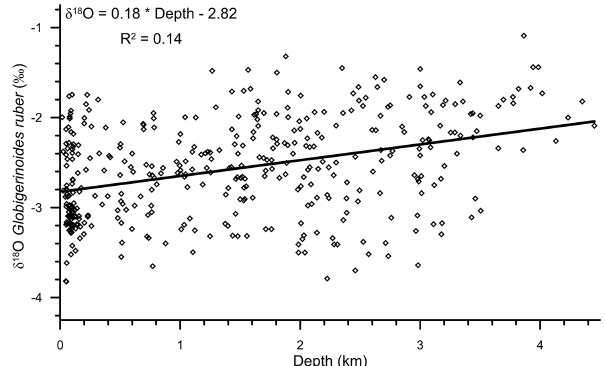
Figure 5. The relationship between water depth and the oxygen isotopic ratio of the mixed-layer-dwelling Globigerinoides ruber in the surface sediments of the northern Indian Ocean. The trend line signifies the relative enrichment of δ 18 O ruber shells in surface sediments, with increasing water depth. The empirical relationship between the water depth and δ 18 O ruber is represented with an equa- tion. The δ 18 O ruber is significantly correlated ( R 2 = 0 . 14; n = 400) with the water